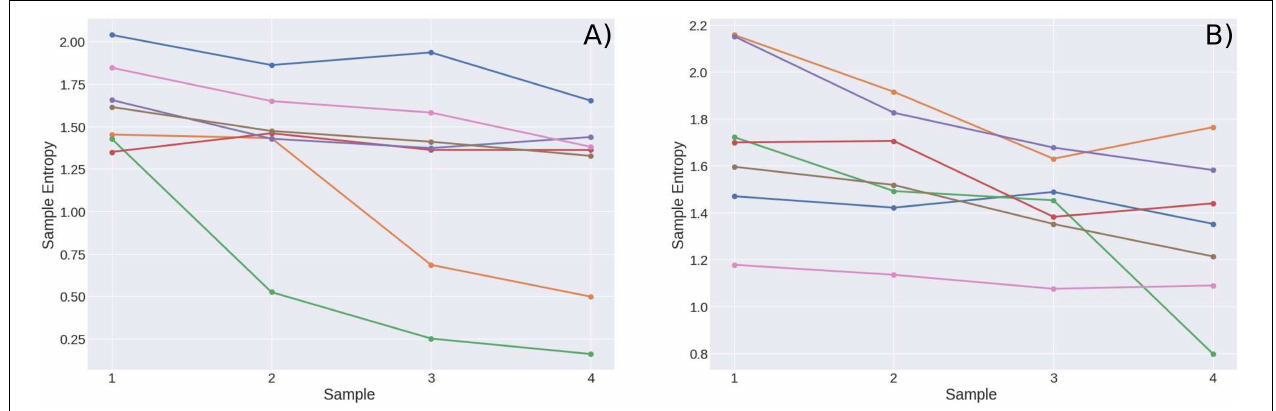
FIGURE 8 | Results of sample entropy for 1-h cardiac stress tests in (A) a treadmill at 3.5 mph and (B) a track at approximately 3.5 mph.